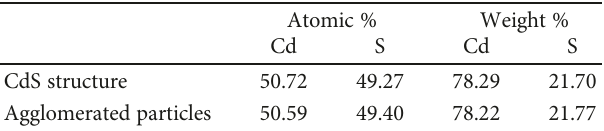
Table 2: The compositional analyses of the CdS structure and agglomerated particles.